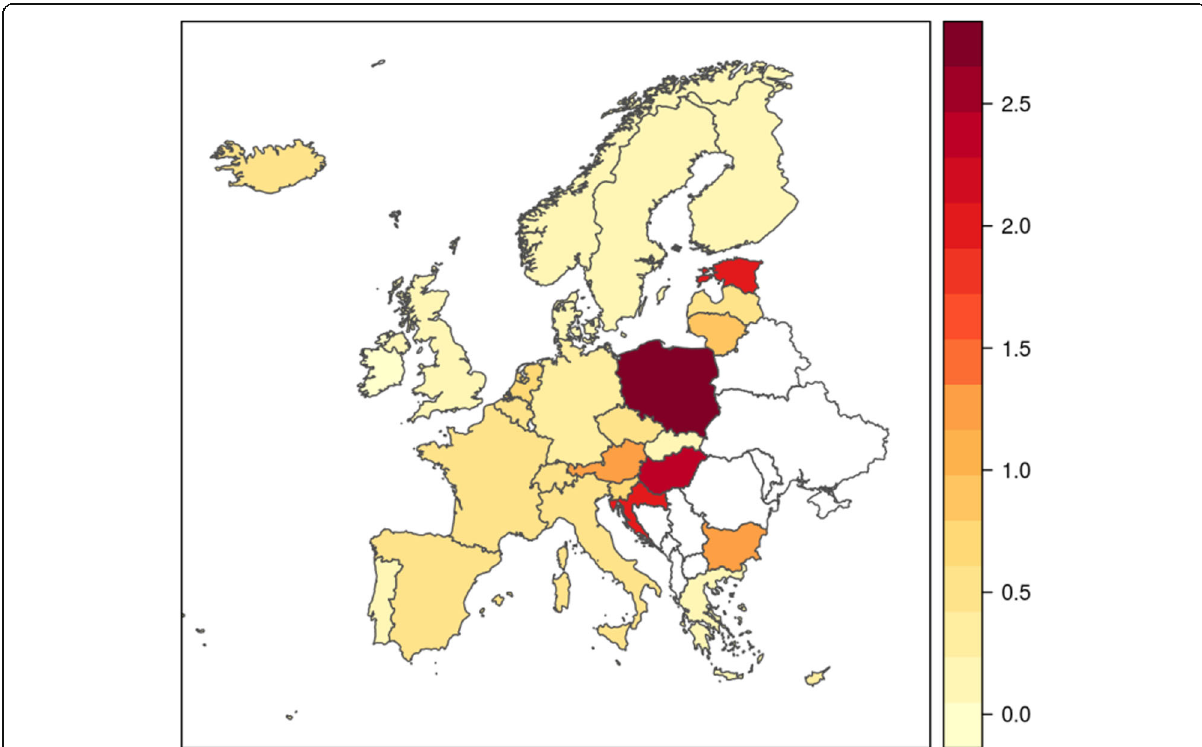
Fig. 2 Total costs related to serious injuries as percentage of